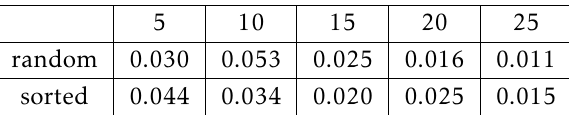
Table 3. Probability of False